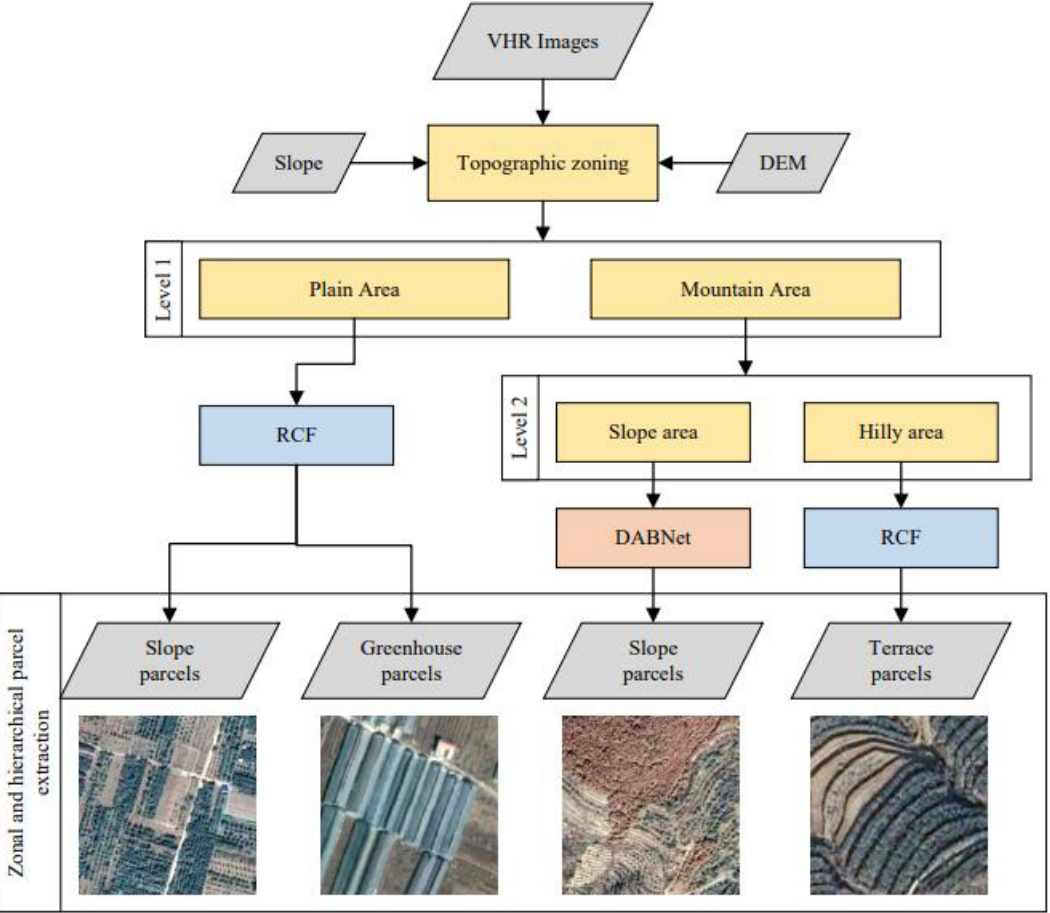
Figure 4. Parcel extraction flow chart.